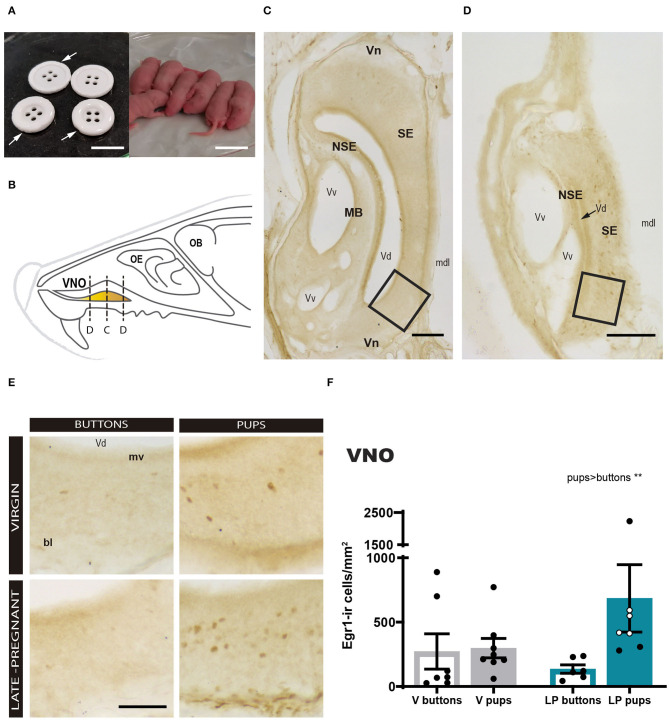
Expression of Egr1 in the vomeronasal organ (VNO) of females (virgin or late-pregnant) exposed to pups or buttons. Buttons are of a size comparable to pups (A) and are not avoided but actually gnawed (arrowheads point to notches). Diagram of the VNO (B) illustrating the levels of the sections shown in (C,D), which are two low-power photographs of the VNO showing the main anatomical landmarks at two different antero-posterior levels (C, center of the VNO; D, tip of the VNO). Examples similar to the framed areas in (C,D) are shown at higher magnification in (E) for each experimental group. A bar histogram of raw data (mean ± SEM) of Egr1-positive cells in the VNO of the different groups is shown in (F), where individual data are also plotted. The empty circles correspond to those females displaying pup-directed aggression. Statistical analysis of the density was performed on the log transformed values to achieved normality and homocedasticity (see text). Egr1 expression is increased in response to pups (**p < 0.01) as compared to a socially neutral stimulus (buttons), but there is no difference between virgin and late-pregnant females. Scale bars: (A) 2 cm; (C,D) 100 μm; (E) 50 μm.